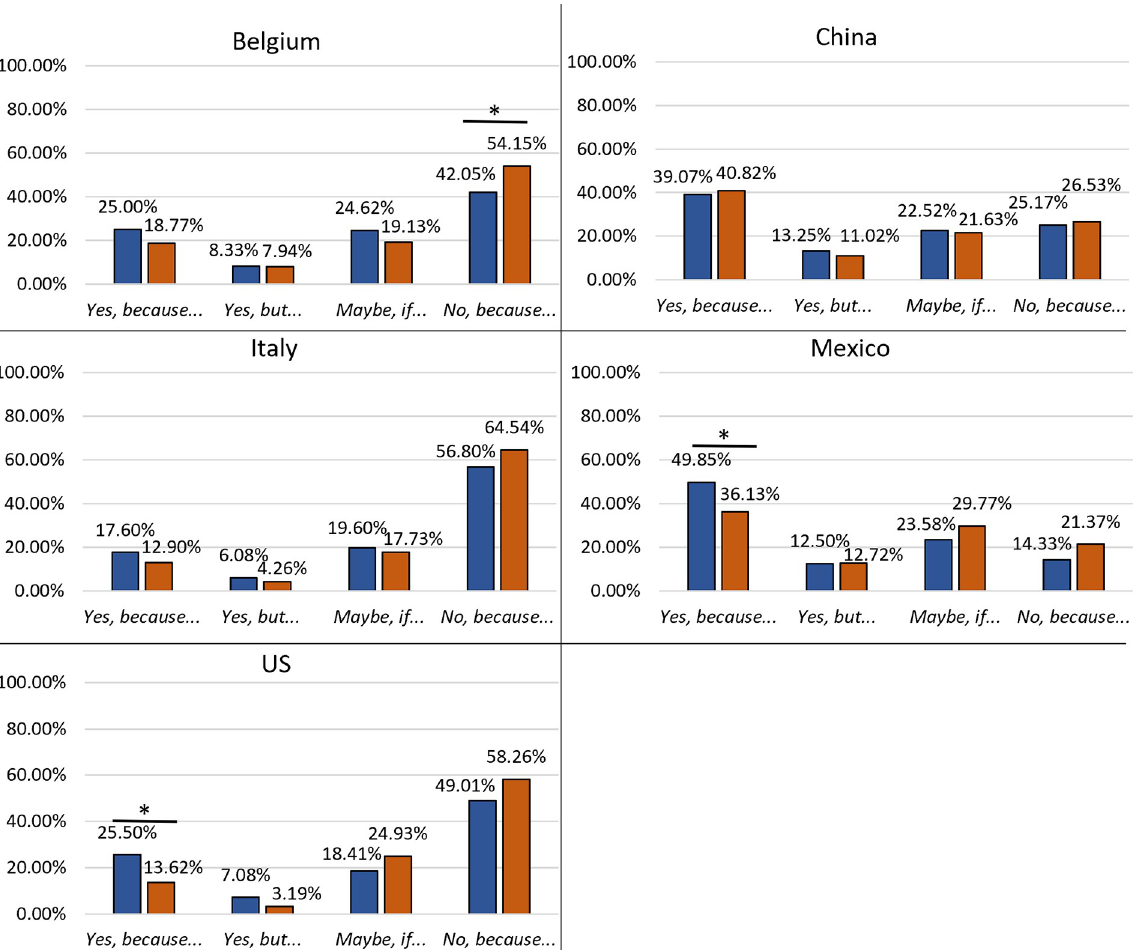
Fig 3. Effects of gender on the acceptance level of the inclusion of processed mealworms in the diet in different countries. Male: blue columns; Female: orange columns. � Significant difference assessed by Chi 2 test of homogeneity with post hoc test (z-test of two proportions) with Bonferroni’s correction ( P <